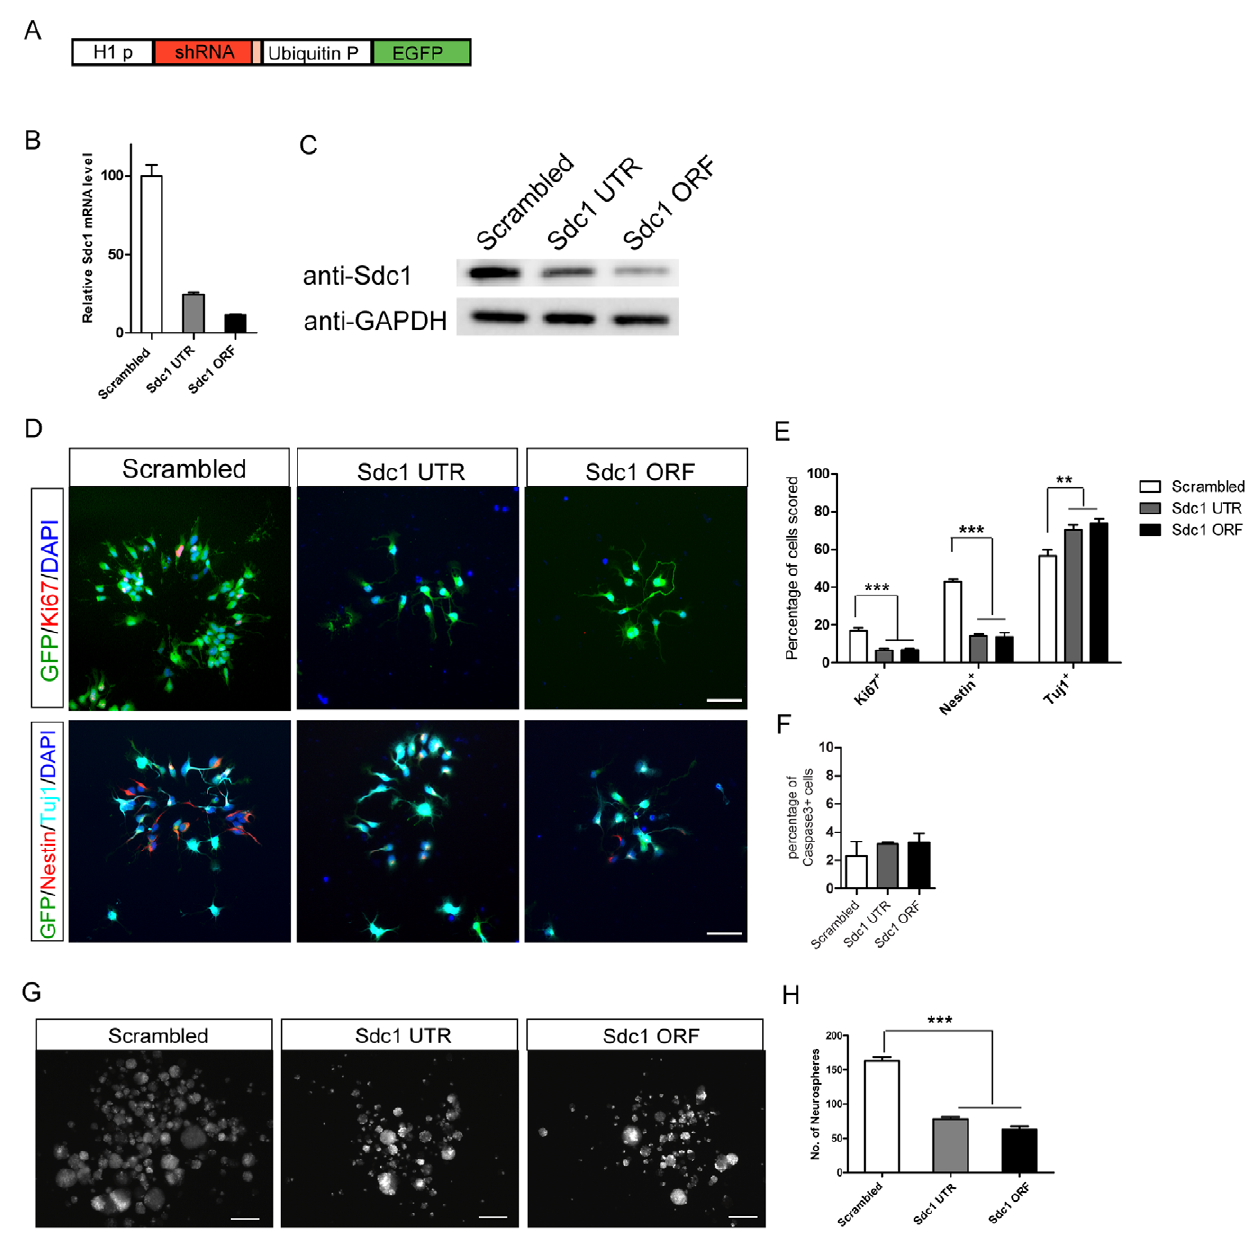
Figure 2. Sdc1 knockdown reduces NPC maintenance and proliferation in vitro. (A) The FUWG H1 lentiviral vector expresses a shRNA under the H1 promoter and eGFP under the ubiquitin promoter. Two different shRNAs (Sdc1 UTR and Sdc1 ORF) specifically targeting Sdc1 inhibit Sdc1 expression at mRNA (B) and protein (C) levels. (D) E11 cortical NPCs were treated with scrambled control, Sdc1 UTR and Sdc1 ORF lentiviruses and assessed at 4 DIV. Knocking down Sdc1 reduces the NPC population and their proliferation, indicated by Nestin and Ki67, respectively; knocking down Sdc1 also promotes neuronal differentiation, indicated by Tuj1 staining (scale bar=50 um). Data are quantified in (E). (F) Knocking down Sdc1 does not increase cell apoptosis, assessed by active Caspase-3. (G) Knocking down Sdc1 reduces neurosphere generation, assessed at 7 DIV and quantified in (H) (N=3) (scale bar=200 um). Error bars represent S.E.M, *P , 0.05, **P , 0.01, ***p , 0.001.